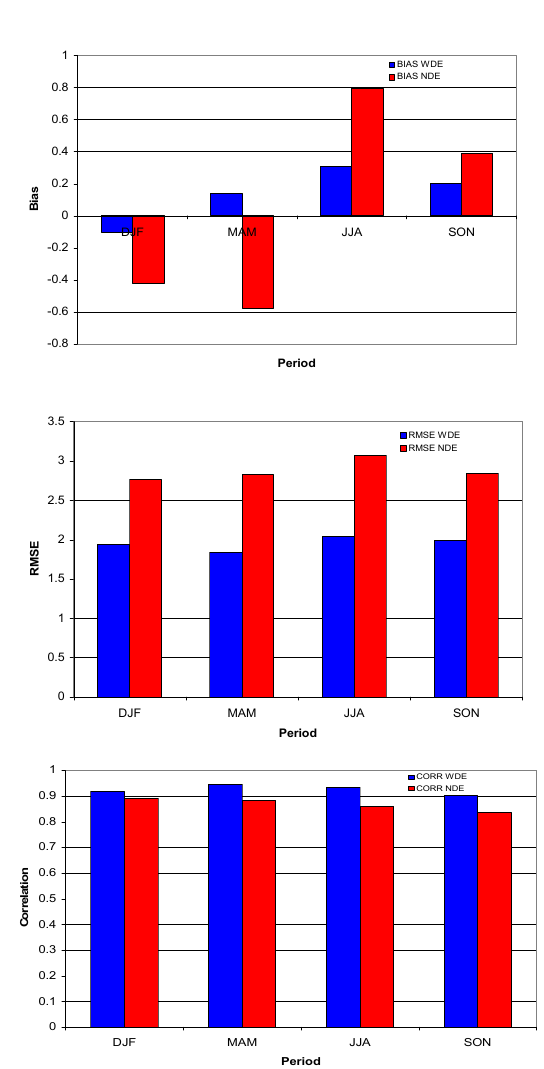
Fig. 6. Statistical parameters: bias (upper), RMSE (middle), correla- tion coefficient (lower) for the 6-year period of simulations (2002– 2007) with dust effects (WDE) and without dust effects (NDE) for the surface